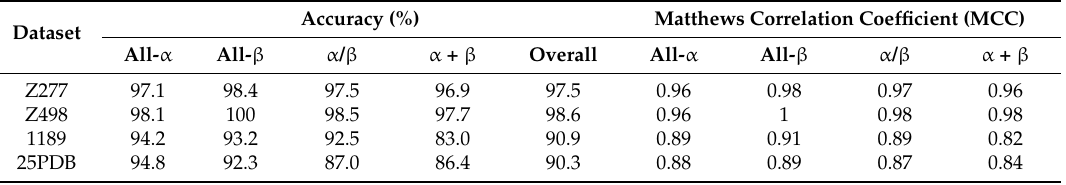
Table 1. Prediction performances on four datasets by our